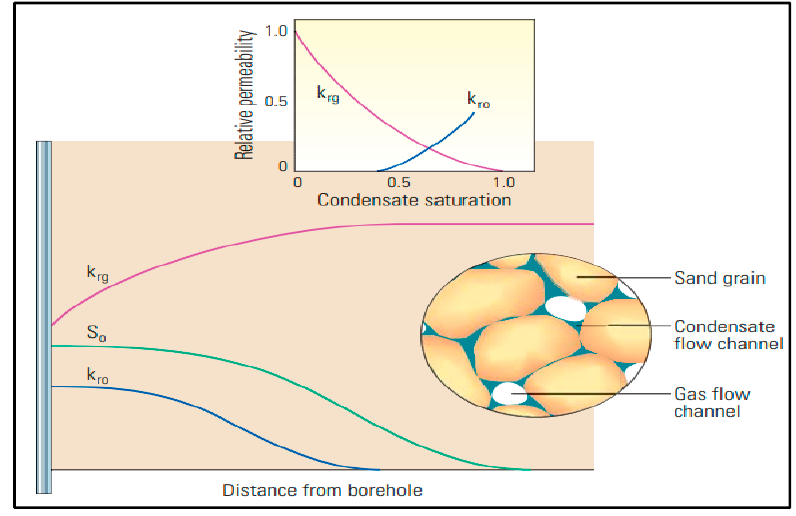
Figure 1. Condensate blockage schematic with reflection to relative permeability curves [4].